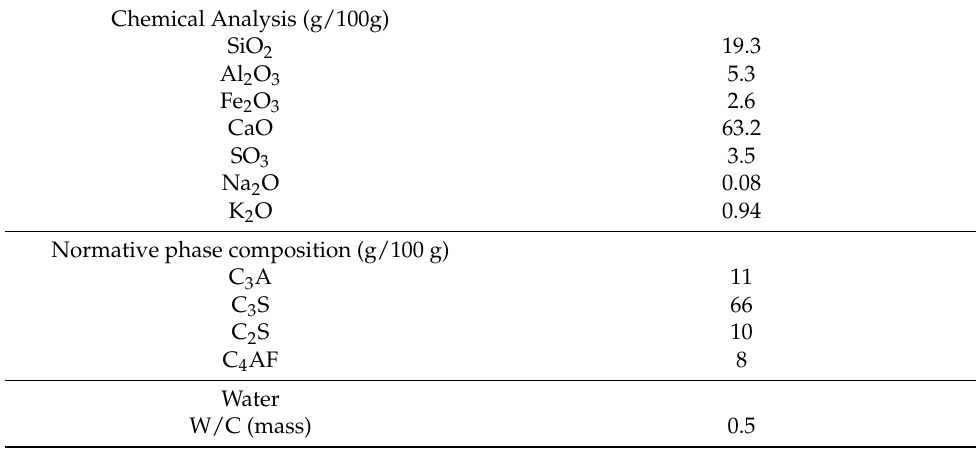
Table 1. Composition of the CEM I